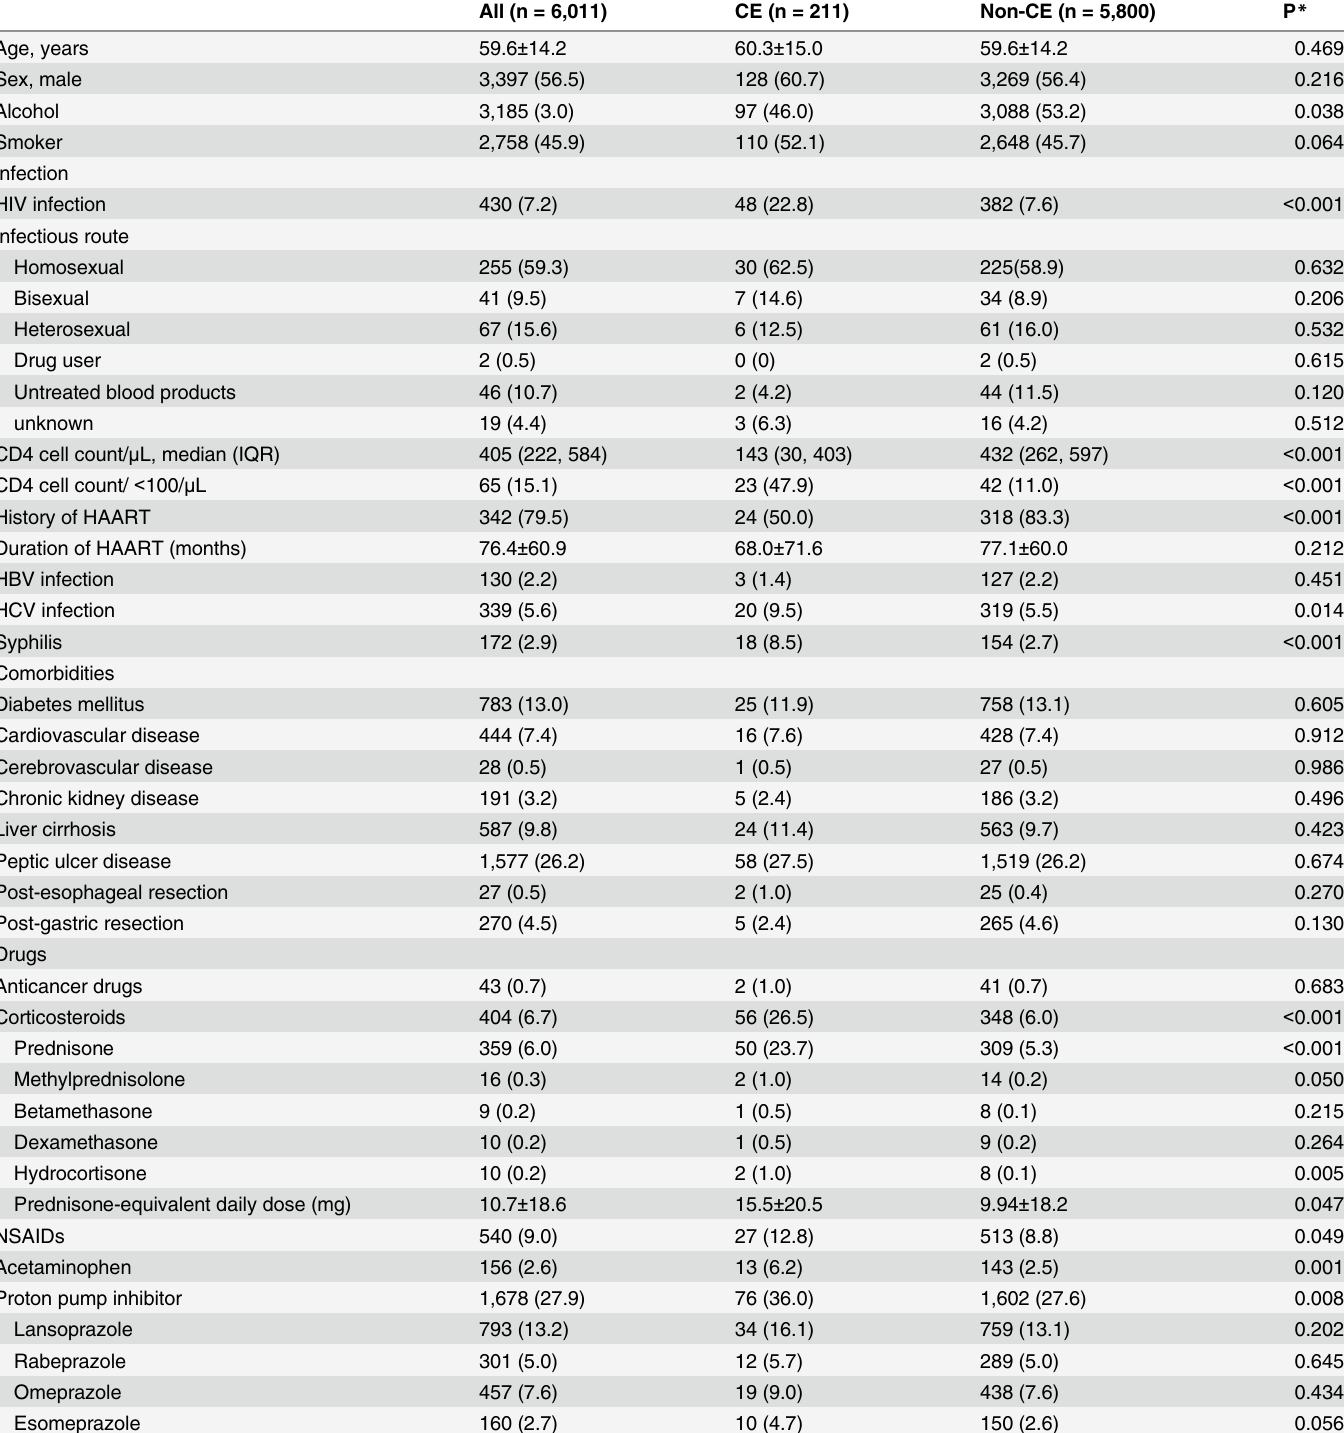
Table 1. Patient characteristics in the entire cohort and groups with or without candida